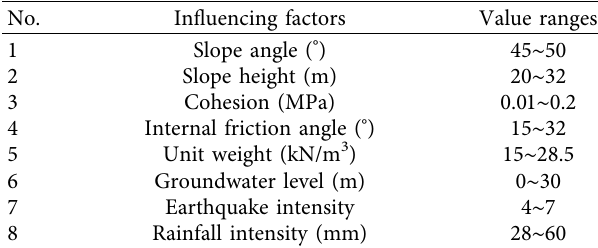
Figure 4: Analysis model of the slope. Table 5: Value ranges of the influencing factors.